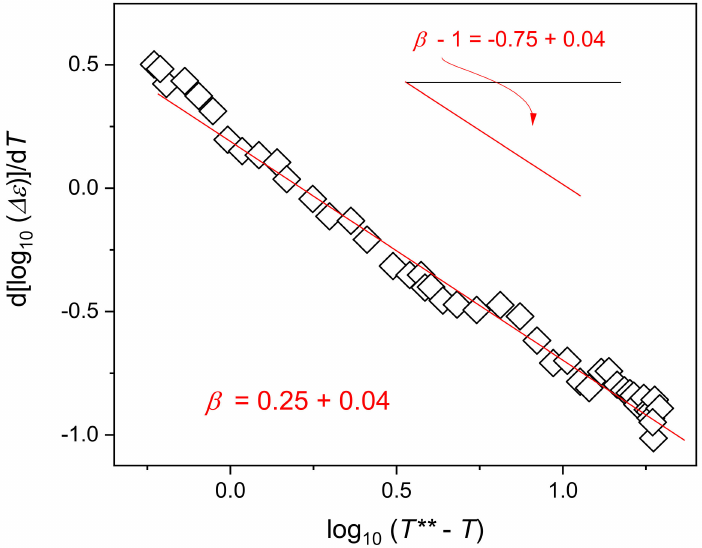
Figure 2. Results of the derivative-based analysis of the order parameter in the nematic phase of 5CB (see Equation (10). They strongly indicate the tricritical value of the order parameter exponent β ≈ 1/4, well beyond the mean-field value exponent β = 1/2 [3,22].